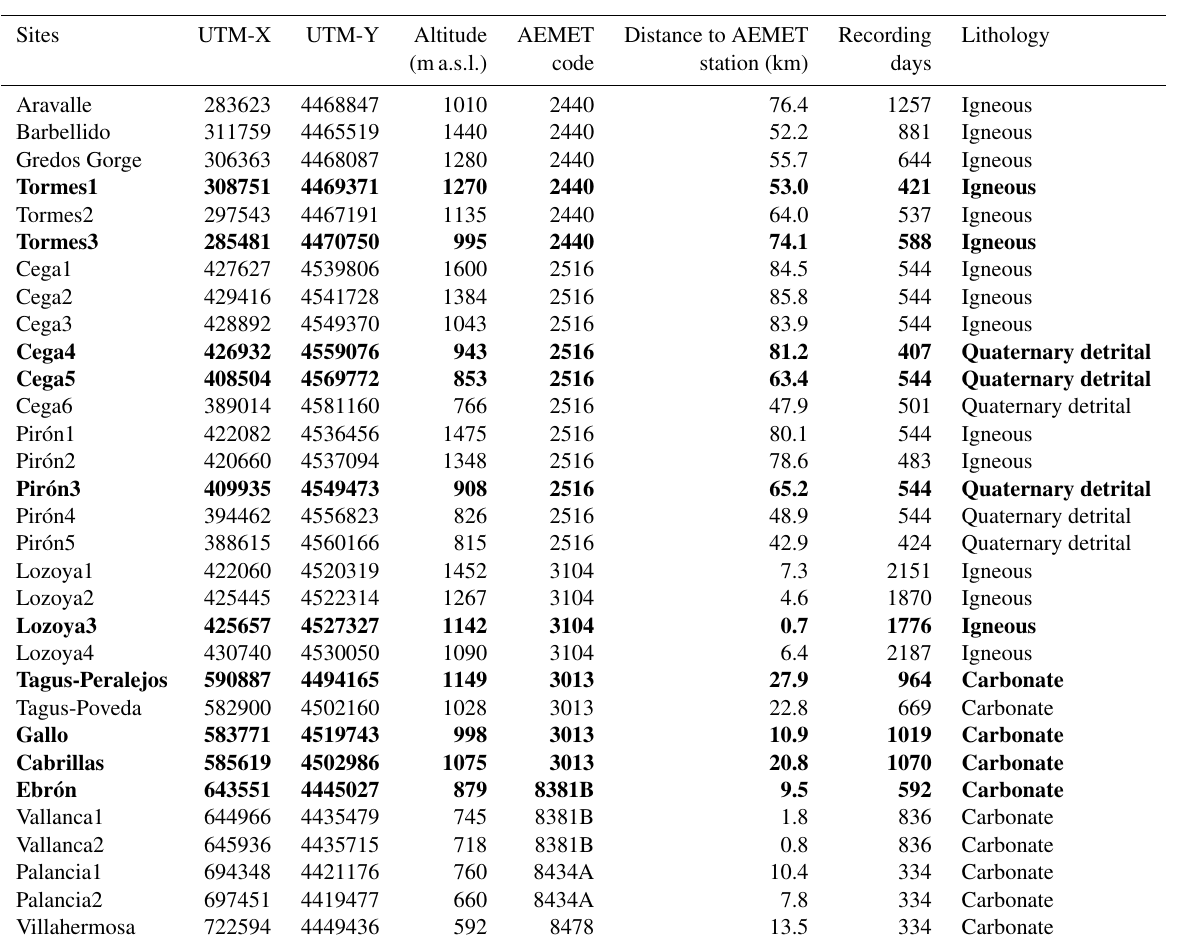
Table 1. Description of the data logger (thermograph) sites, specifying given name, UTM coordinates (Europe WGS89), altitude (metres above sea level), code of the nearest temperature meteorological station with suitable time series for this study (AEMET: Spanish Meteoro- logical Agency), orthogonal distance between the data logger and the meteorological station, number of recorded days for stream temperature and characteristic geological nature (lithology) of the data logger site (the last of which was obtained from IGME, 2015). Bold letters indicate sites associated with the gauging